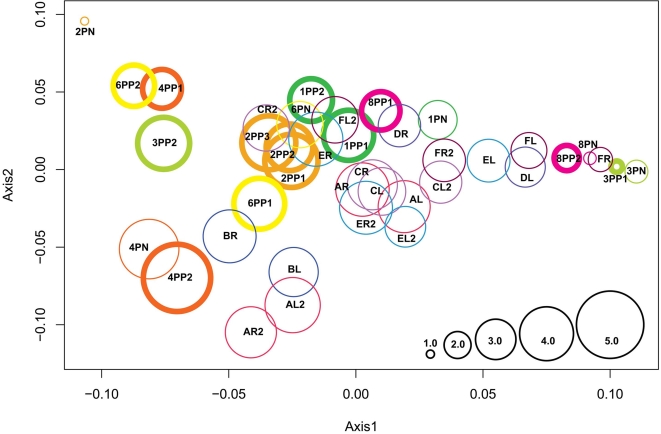
DPCoA of SLOTU relatedness in 39 human skin samples obtained from healthy subjects and psoriatic patients.The healthy subjects were designated A–F, and at each sampling both left (L) and right (R) forearm skin was examined. In four subjects, new specimens were obtained 8–10 months later (e.g. designated AL2). The psoriatic patients were designated 1, 2, 3, 4, 6, and 8, PN indicates that sample is from uninvolved skin and PP is from psoriatic lesions. In a representation of the first two orthogonal principal axes, based on a sample dissimilarity matrix, samples from the same subjects at the same time point are plotted by using the same color, and the normal skin and psoriatic lesion samples are indicated by thin and thick circle walls, respectively. The size of each circle is proportional to the sample's Rao diversity index. The scale (bottom right) indicates the relative diversity of the populations within the circles, with the test sample of smallest diversity (2PN) indexed as 1.0.